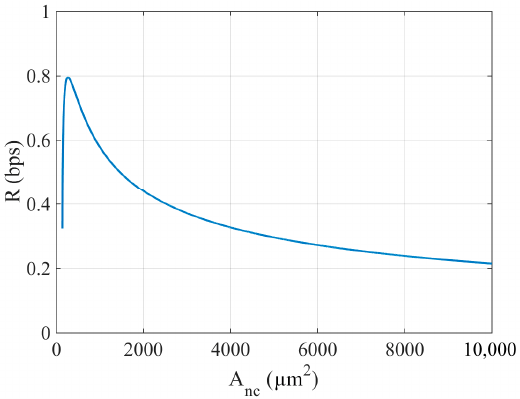
Figure 4. Bitrate per nanodevice as a function of the nanocapacitor area.